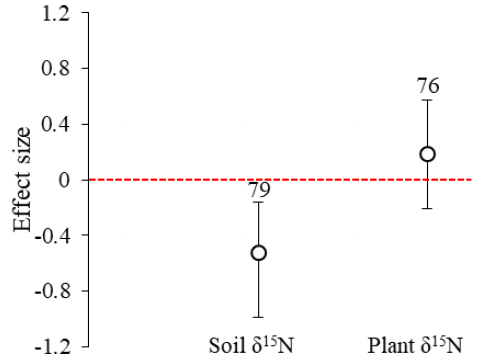
Figure 1. Effect sizes of the experimental warming on soil and plant δ 15 N from a global meta-analysis of 20 studies. The error bars in- dicate effect sizes and 95% bootstrap confidence interval (CI). The warming effect was statistically significant if the 95% CI did not bracket zero. The sample size for each variable is shown next to the